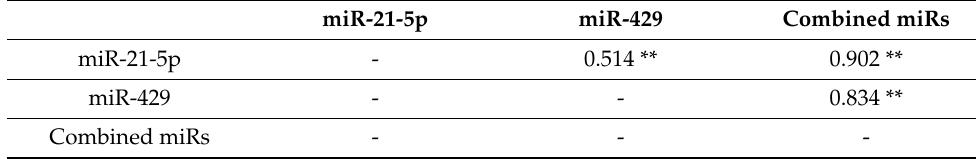
Table 3. Correlation between the expressions of miRNAs.